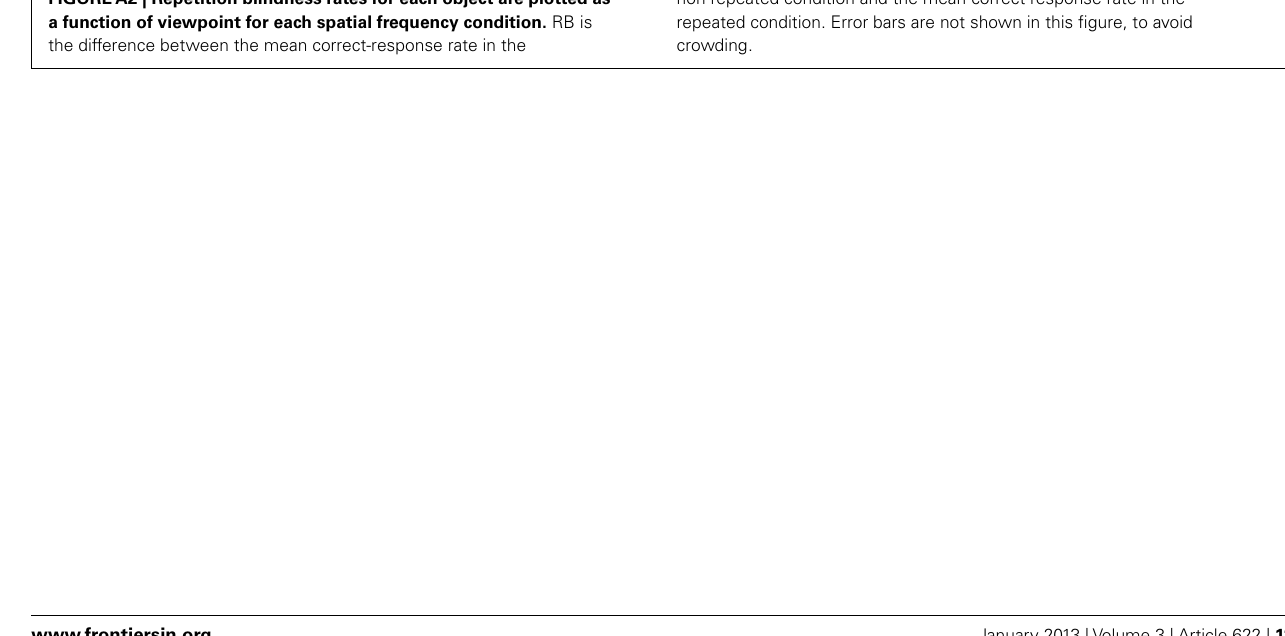
FIGUREA2 | Repetition blindness rates for each object are plotted as a function of viewpoint for each spatial frequency condition. RB is the difference between the mean correct-response rate in the